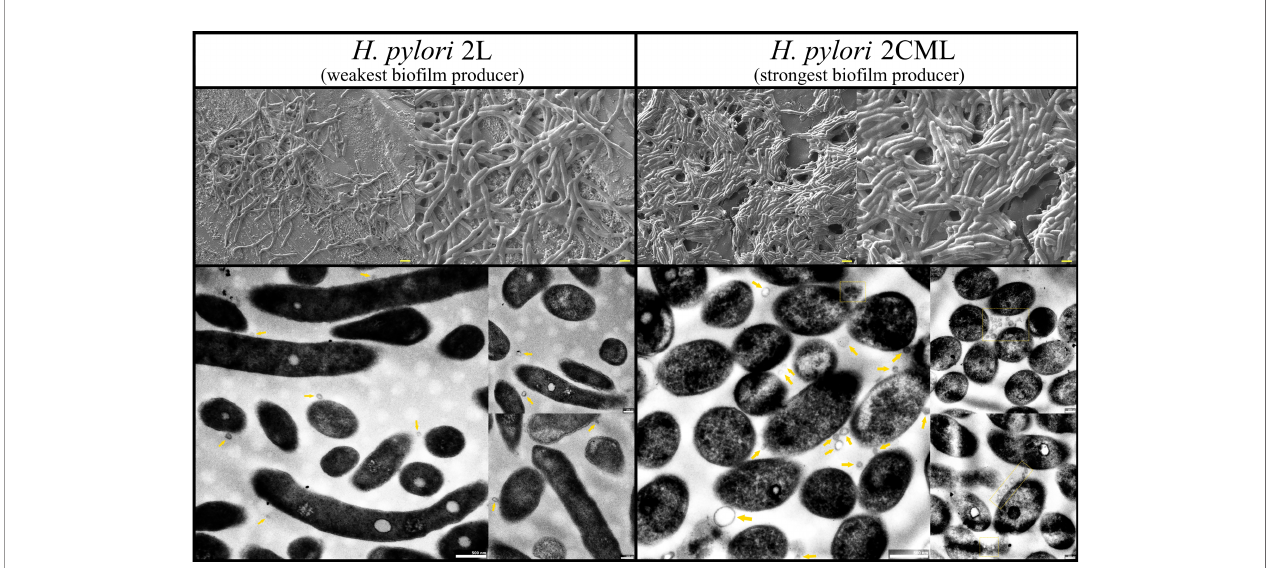
FIGURE 6 | Representative SEM (top) and TEM (bottom) photographs of bacterial aggregates formed after a 1-h incubation of H. pylori 2L and H. pylori 2CML strains. The arrows point a single OMV, while the squares with a dashed line indicate a grouping of these structures. Scale bars for SEM show 2 µm and 1 µm for low- and high-magni fi cation pictures,